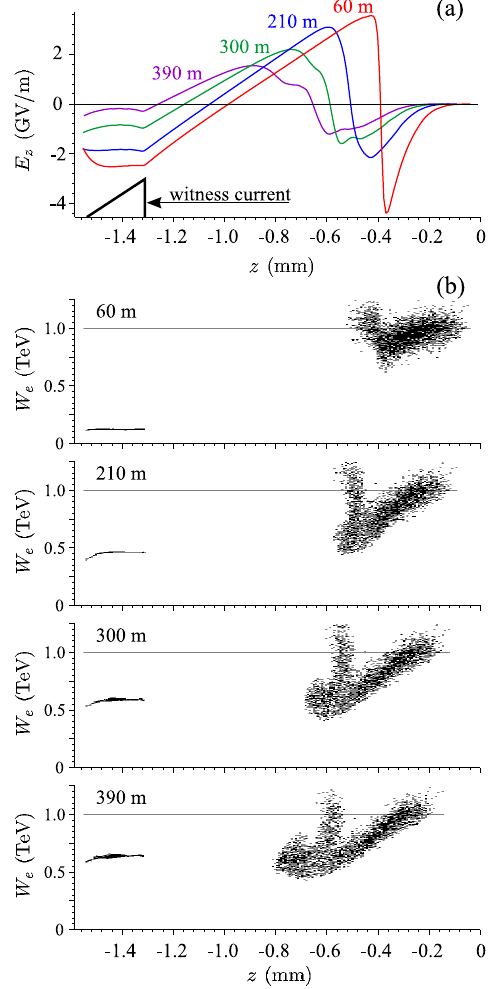
FIG. 9. (Color) On-axis electric field (a) and longitudinal phase portrait of beams (b) at several propagation distances. The black triangle shows charge distribution and location of the witness